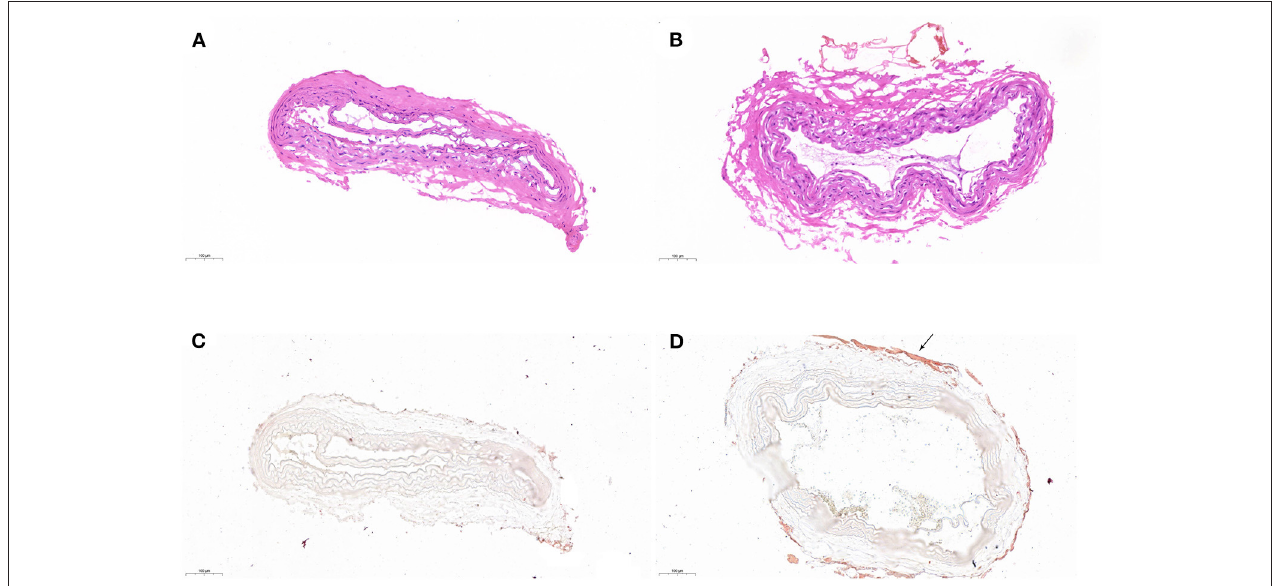
Frontiers in Surgery |